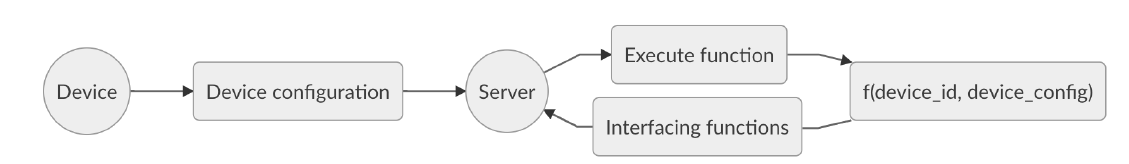
Figure 3. Device configuration